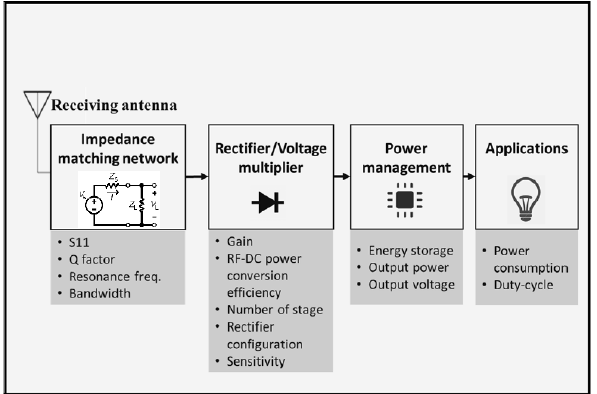
Figure 4. Rectenna architecture for RF power harvesting